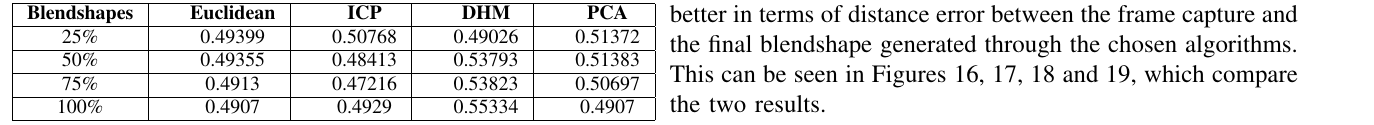
process the blendshapes for this dataset can be seen.